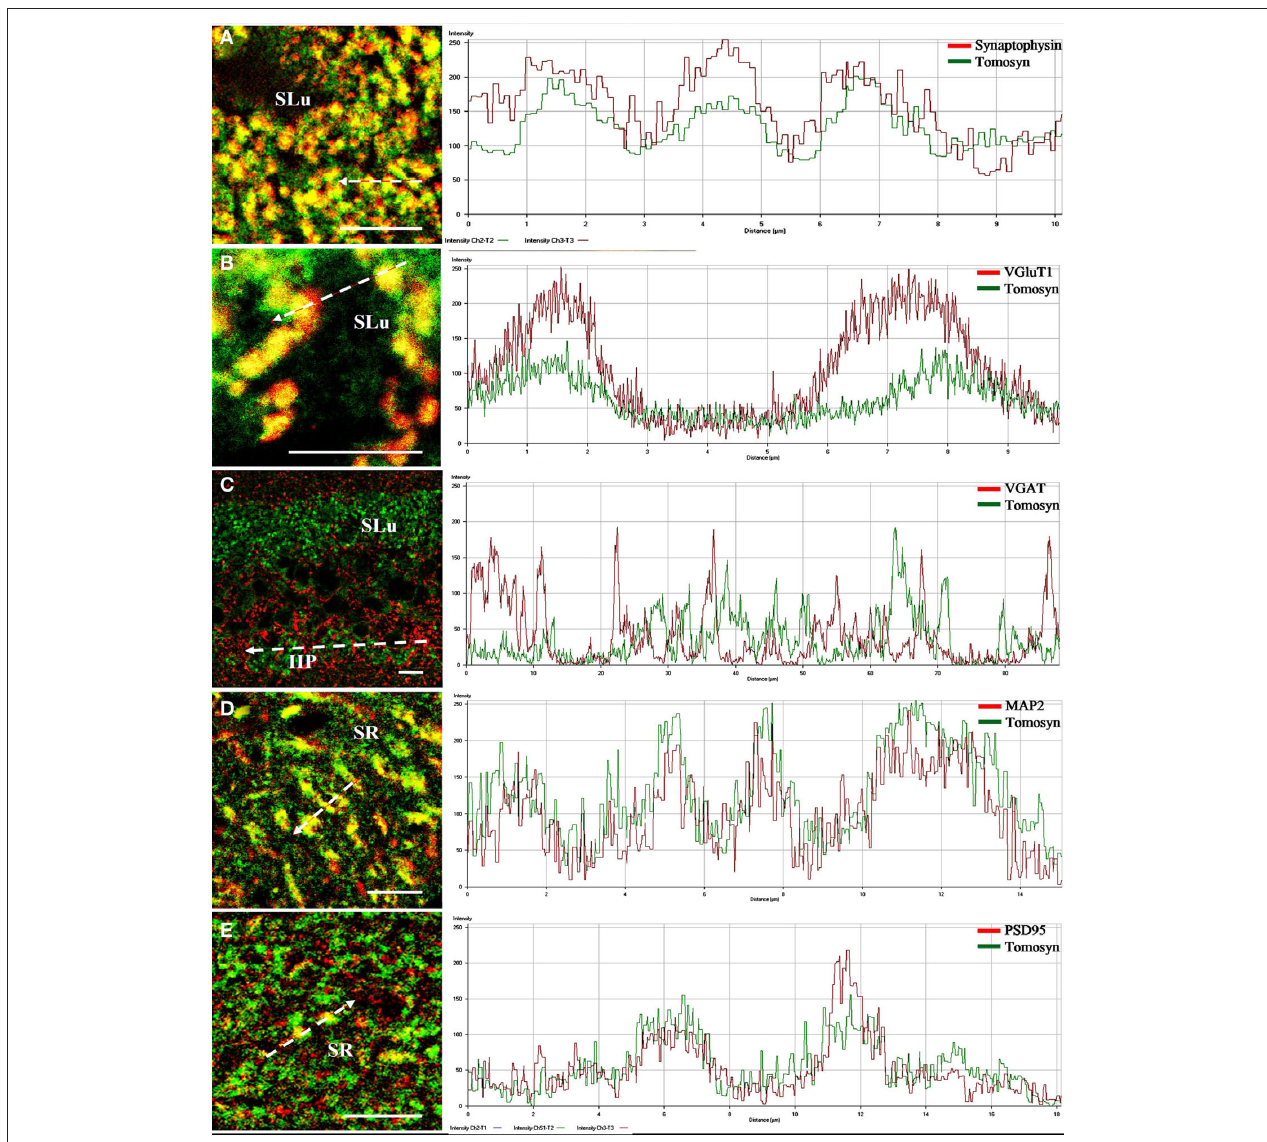
VGAT in the stratum lucidum and intra- and infrapyramidal of the mossy fibers, (D) MAP2 in the stratum radiatm of CA2, (e) PSD95 in the stratum radiatum of CA2. SR, stratum radiatum of CA2; SLu, stratum lucidum of the mossy fibers; IIP, intra- and infrapyramidal of the mossy fibers. Scale bar = 10